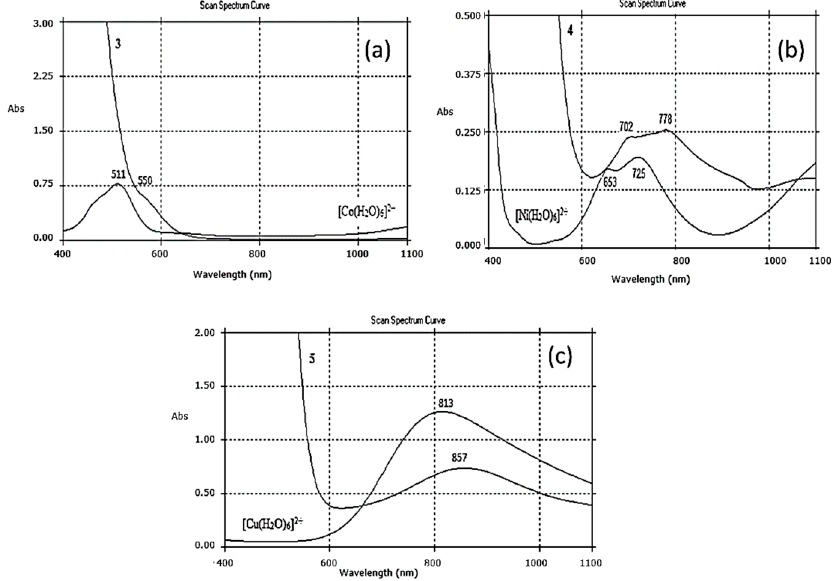
Figure 9. The VIS spectra of ( a ) [Co(H 2 O) 6 ] 2+ and complex 3; ( b ) Ni(H 2 O) 6 ] 2+ and complex 4; and ( c ) Cu(H 2 O) 6 ] 2+ and complex 5.